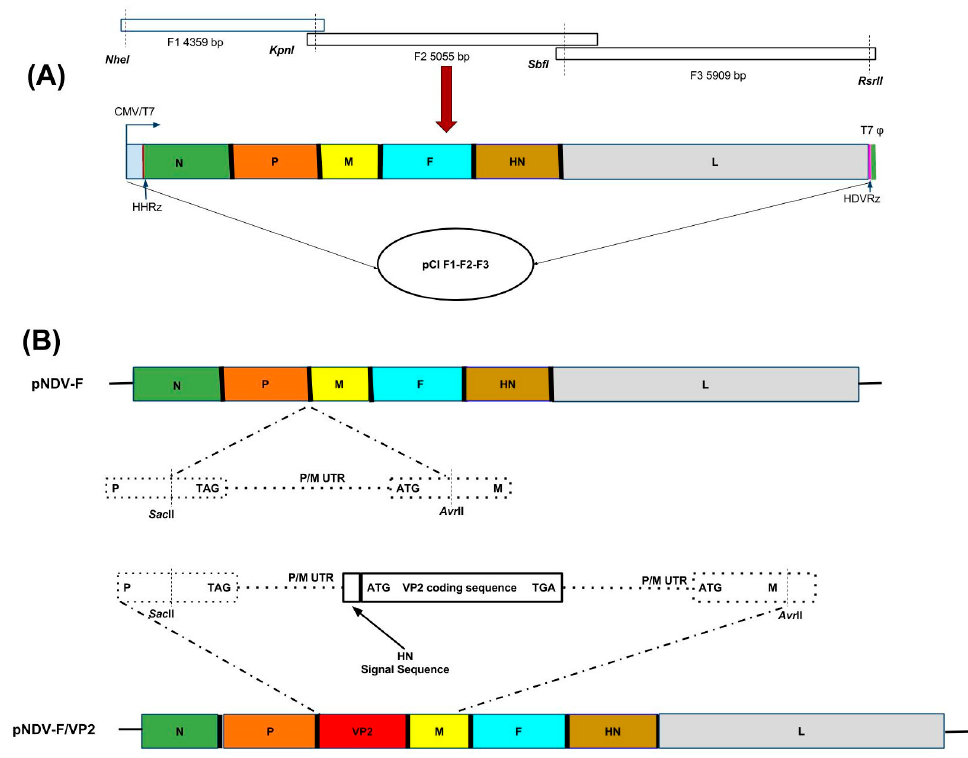
Figure 1. Generation of full-length clone of strain F with and without VP2 gene cassette. ( A ) Schematic representation of the construction of full-length clone pCI F1-F2-F3 of Newcastle disease virus (NDV) strain F. Assembly was carried out by sequential cloning of F1, F2 and F3 fragments into pCI